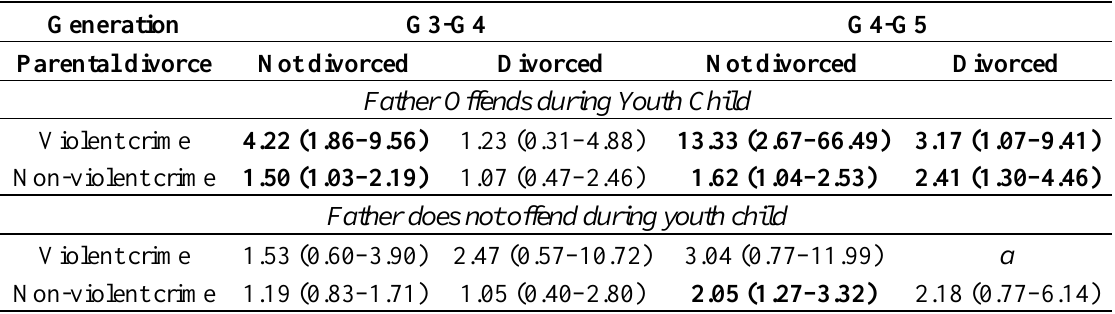
Table 4. GEE models for intergenerational transmission of crime, split by marital status of the parents and the type of